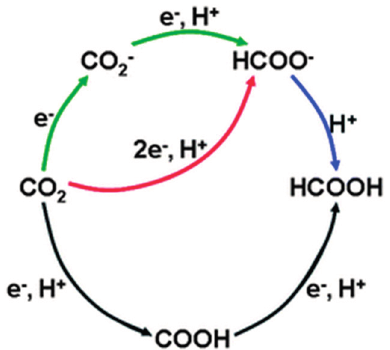
Figure 26. DFT-modeled states of neutral/anionic CO 2 adsorbed on TiO 2 anatase (101) (reproduced from [316] with permission of the Royal Society of Chemistry).